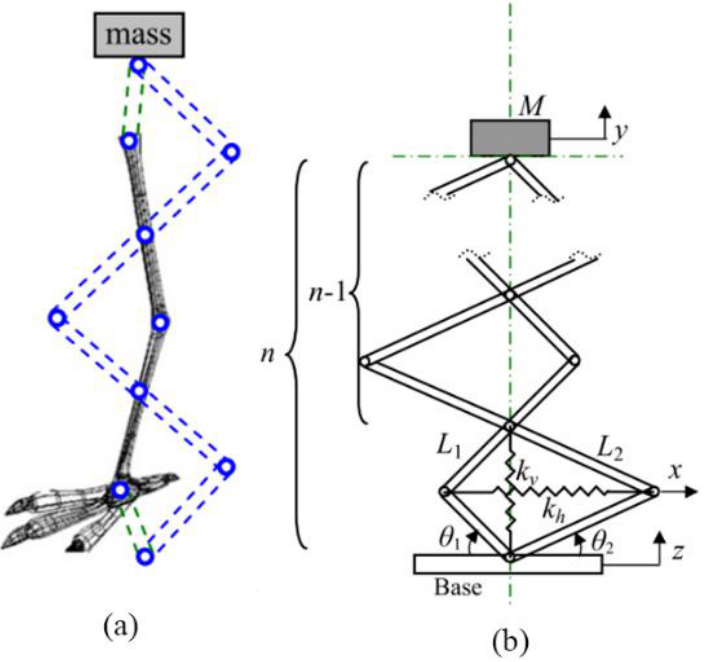
Figure 9. Bionic schematic diagram ( a ) and structure diagram ( b ) of X-shaped bionic vibration control device [49].